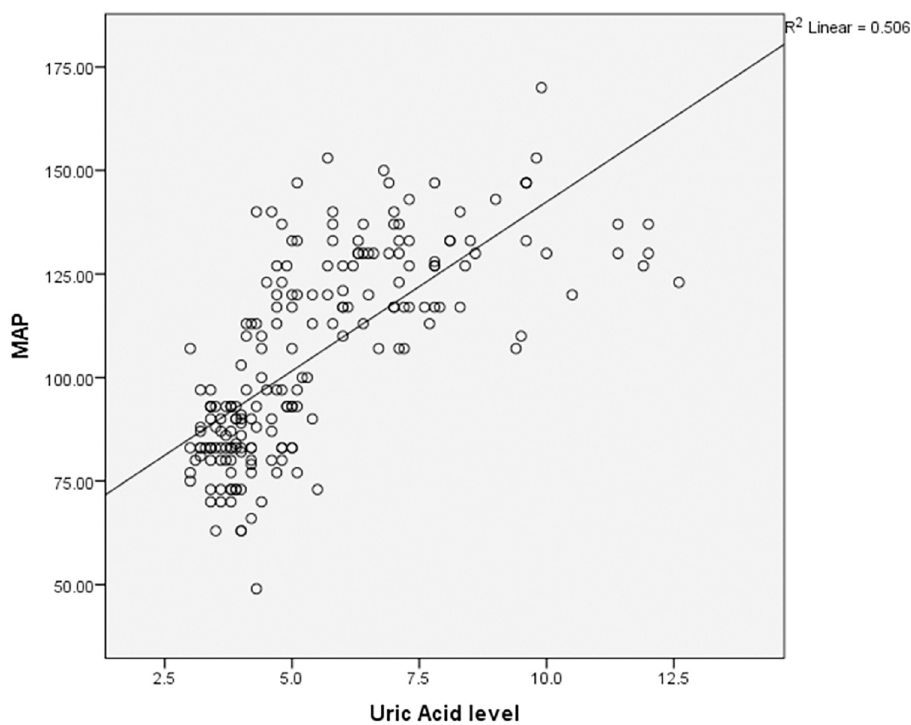
Fig 3. Correlation of uric acid (UA) and mean arterial pressure (MAP) in the study groups (mild and severe preeclampsia). MAP = 16.6667+11.6667 UA (regression equation according to coefficients table) (t = 14.24, p <